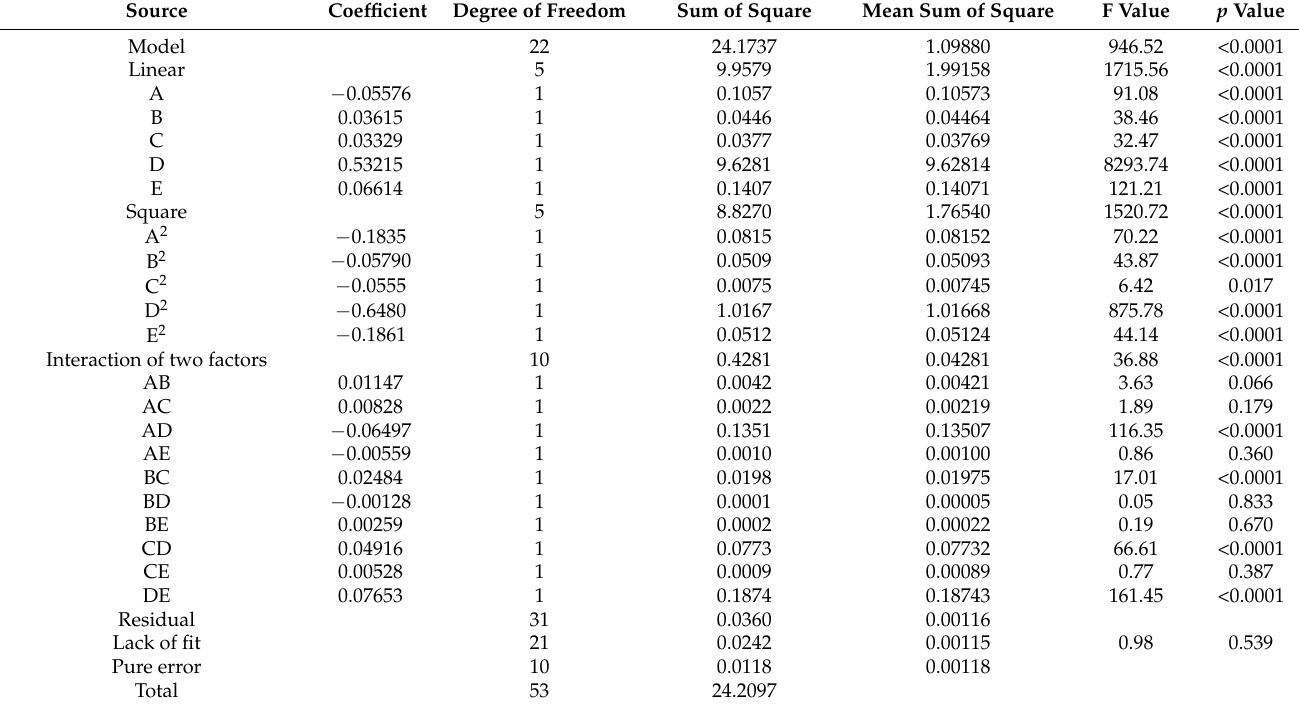
Table 5. Response surface CCD statistics and analysis